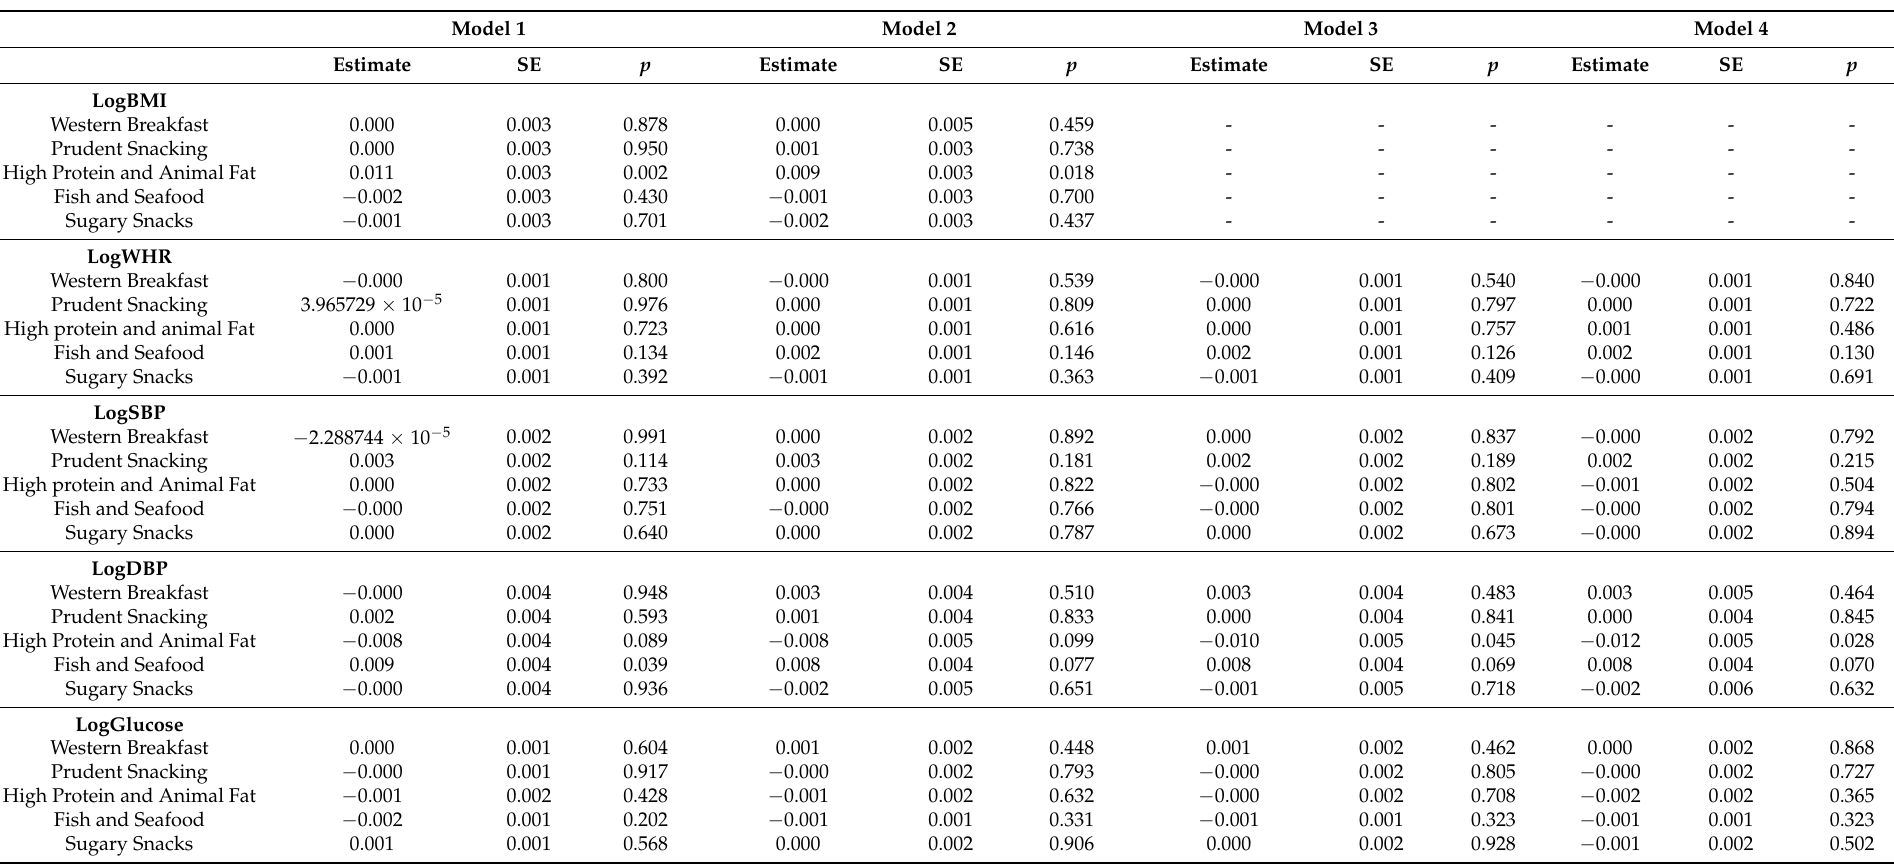
Table 6. Linear mixed model analyses on the association between the dietary patterns, anthropometric indices and biomarkers of glycemic and lipidemic control in the STANISLAS Family